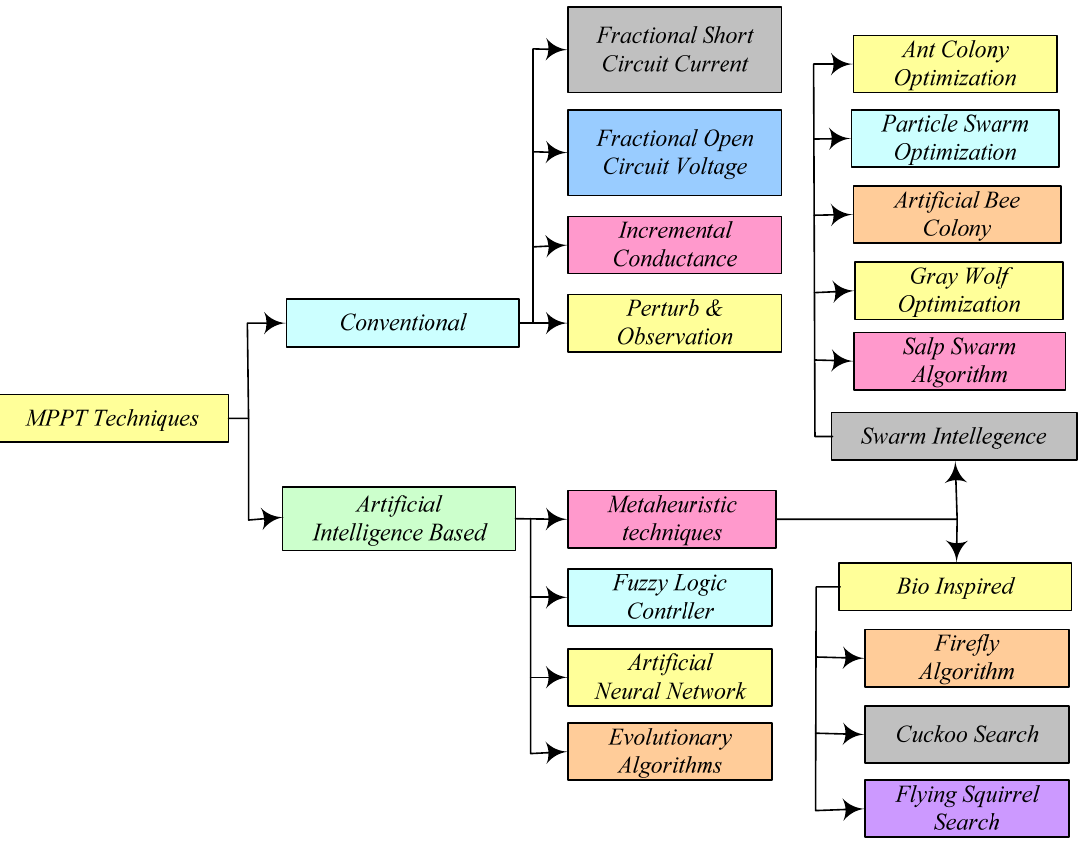
Figure 7. MPPT Techniques Classifications.